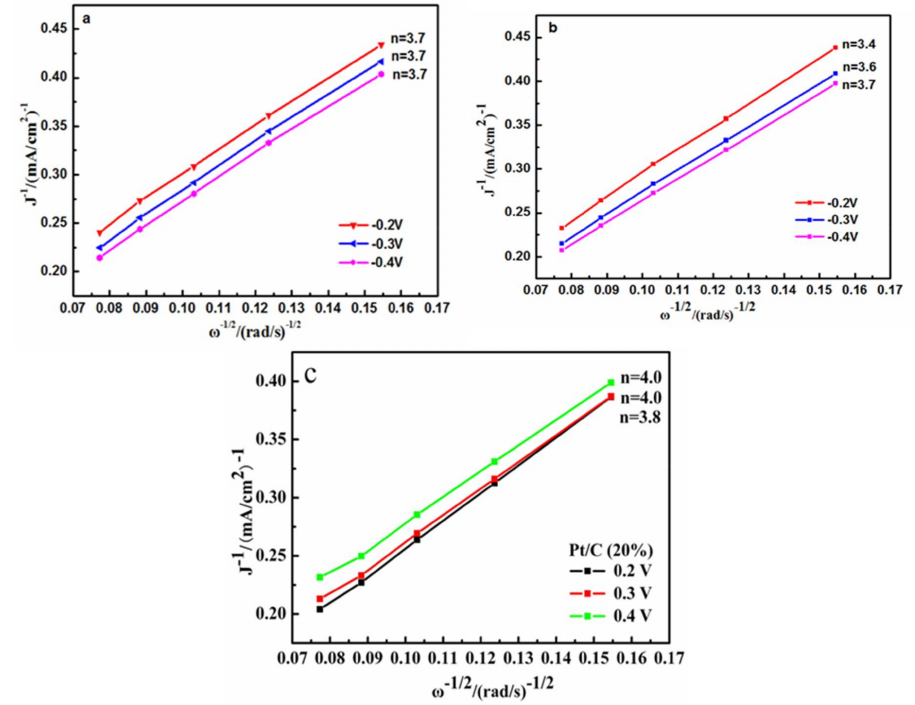
Figure 13. Koutecky–Levich (K-L) plots and electron transfer numbers of Complex 1 /C ( a ), Complex 2 /C ( b ), and Pt/C ( c ) at − 0.2 V, − 0.3 V, and − 0.4 V vs.